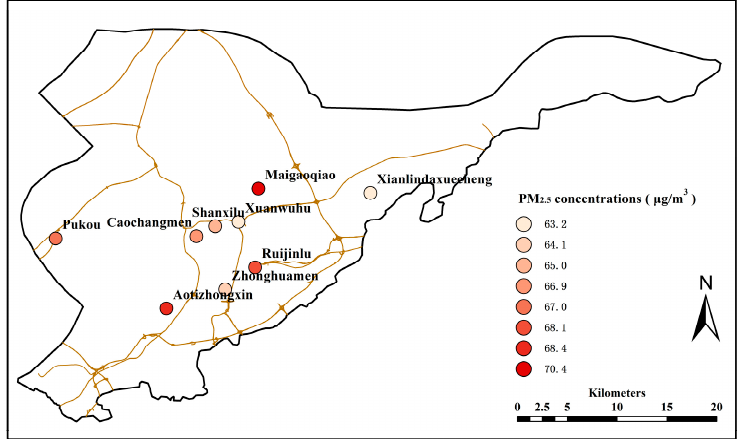
Figure 2. Regional distribution of the average PM 2.5 mass concentrations in the past three years in Nanjing.